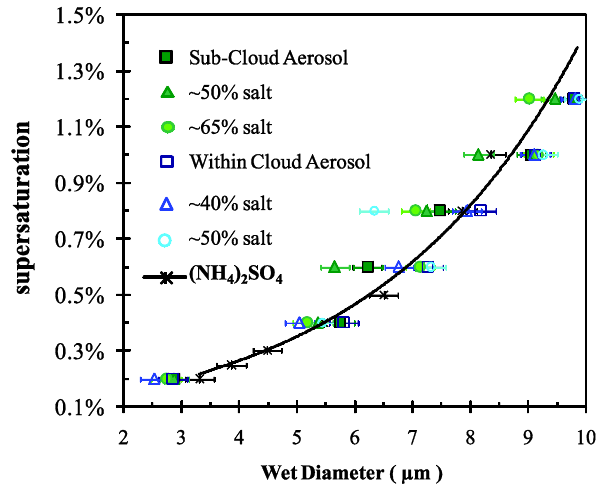
Figure 6. Size of activated CCN generated from the cloud residual samples (CR, solid symbols), sub-cloud samples (SC, open symbols) and (NH 4 ) 2 SO 4 (solid black line). Droplet sizes are presented for CCN with s c equal to the instrument